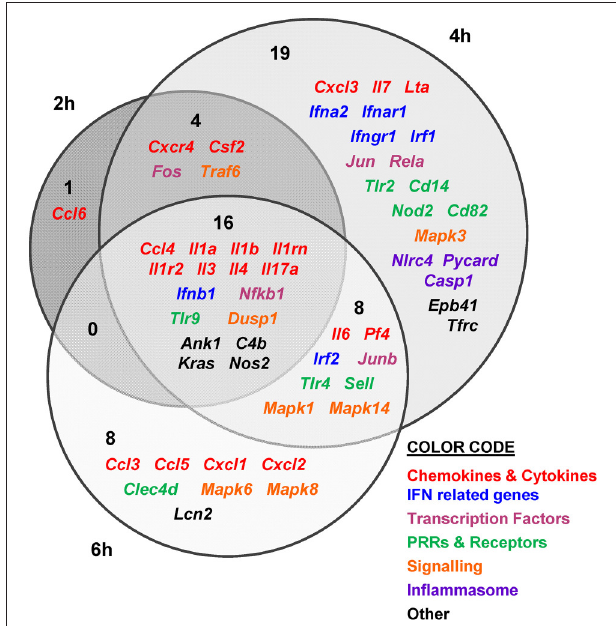
FIGURE 4 | V. vulnificus Bt2-SerE R99 strain induces the early up-regulation of a large number of immune-related genes. Venn diagram depicting the overlap of the 56 immune-related genes that are differently up-regulated between R99 strain infected-mice for 2, 4, or 6 h, when compared with uninfected mice. Only genes up-regulated more than 1.3 were